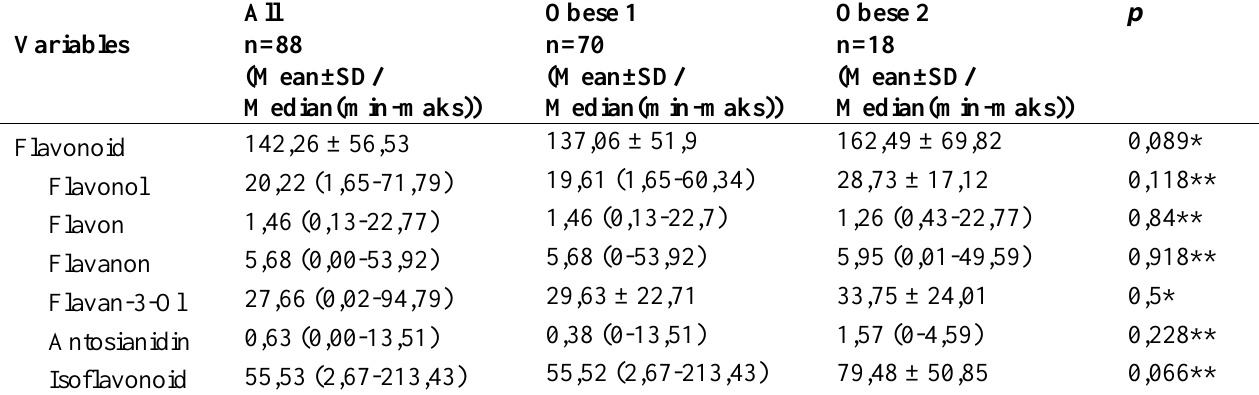
Table 2. Subject’s flavonoid intake